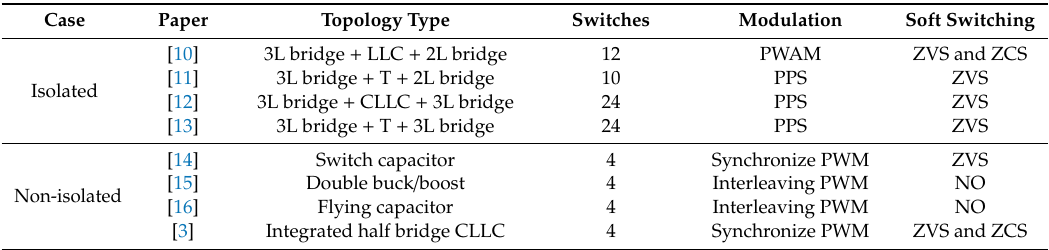
Table 1. Comparison of